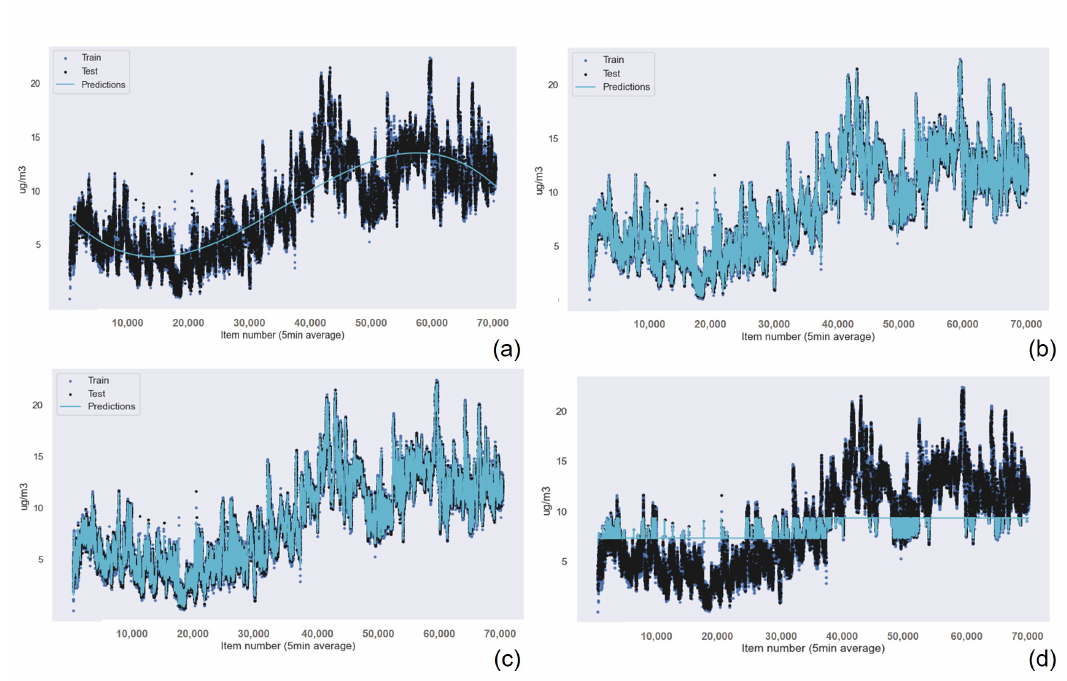
Figure A7. SO 2 results for ( a ) Linear Regression ( b ) Random Forest Regression ( c ) KNN and ( d ) Sup- port Vector Machine.